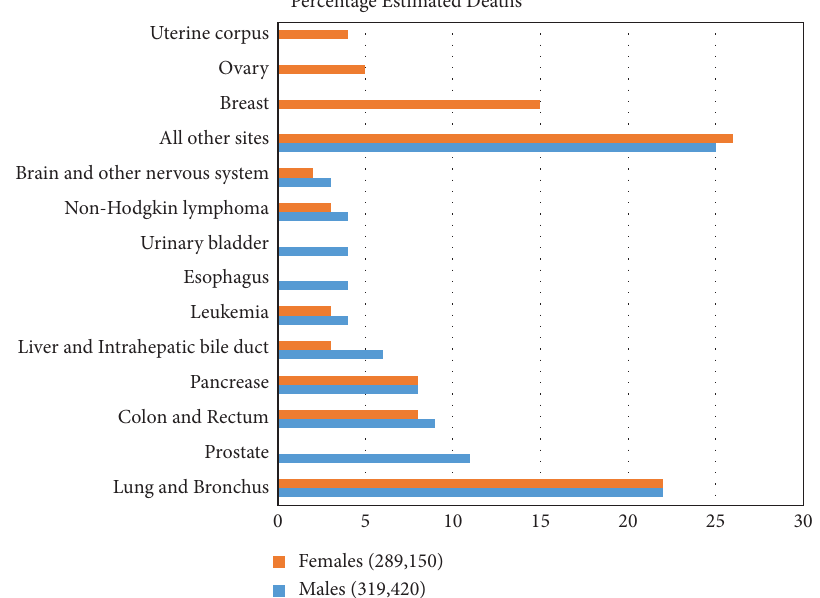
Figure 1: Estimated percentage of deaths from various cancers in the US in